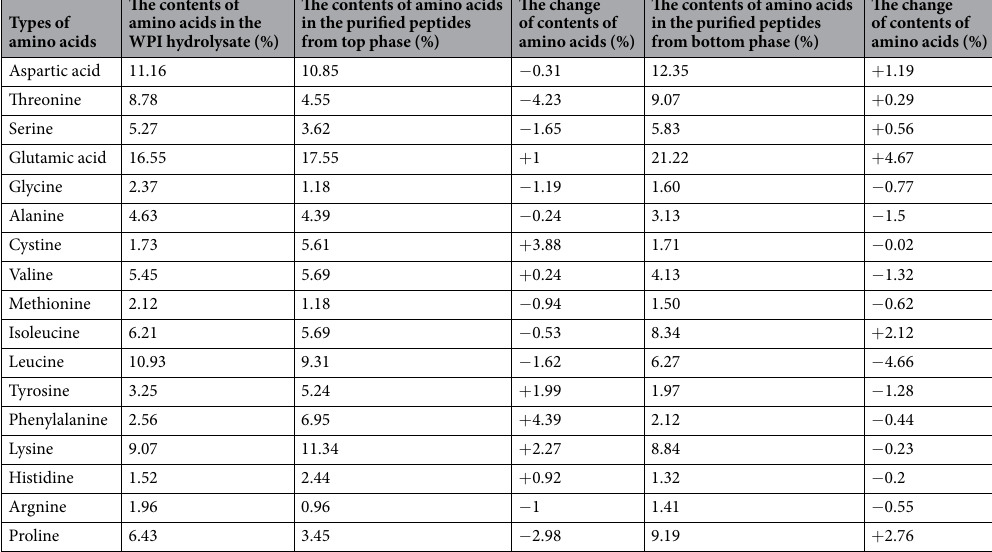
Table 5. Comparison of the types and content of amino